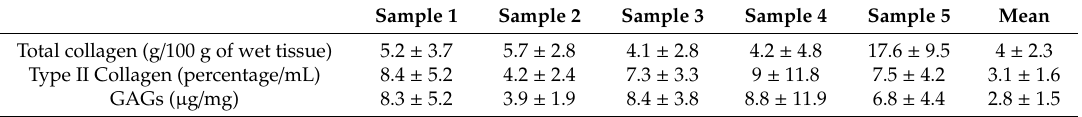
Table 2. Quantifications of total collagen, type II collagen, and glycosaminoglycans (GAGs).